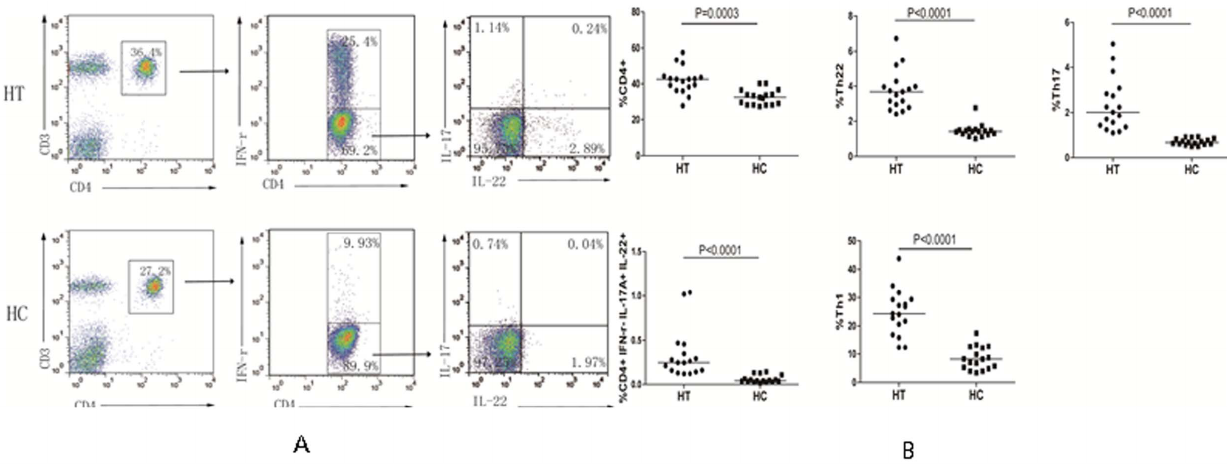
Figure 1. Flow cytometry analysis of the frequency of different subsets of CD4 + T cells. PBMCs were isolated from individual participants and stimulated with PMA and ionomycin for six hours in the presence of BFA. The cells were stained with fluorescent antibodies against CD3 and CD4, fixed and permeabilized, followed by intracellular staining with anti-IFN- c , anti-IL-17A and anti-IL-22. The cells were gated on CD3 + CD4 + T cells and the percentages of IFN- c 2 IL-17A 2 IL-22 + , IFN- c 2 IL-22 2 IL-17A + IFN- c 2 IL-17A + IL-22 + , IFN- c + IL-17A 2 IL-22 2 and IFN- c + CD4 + T cells in CD3 + CD4 + T cells were determined. Data are representative dot plots and the percentages of different subsets of CD4 + T cells in the HT patients and HC. The horizontal lines indicate the median values.